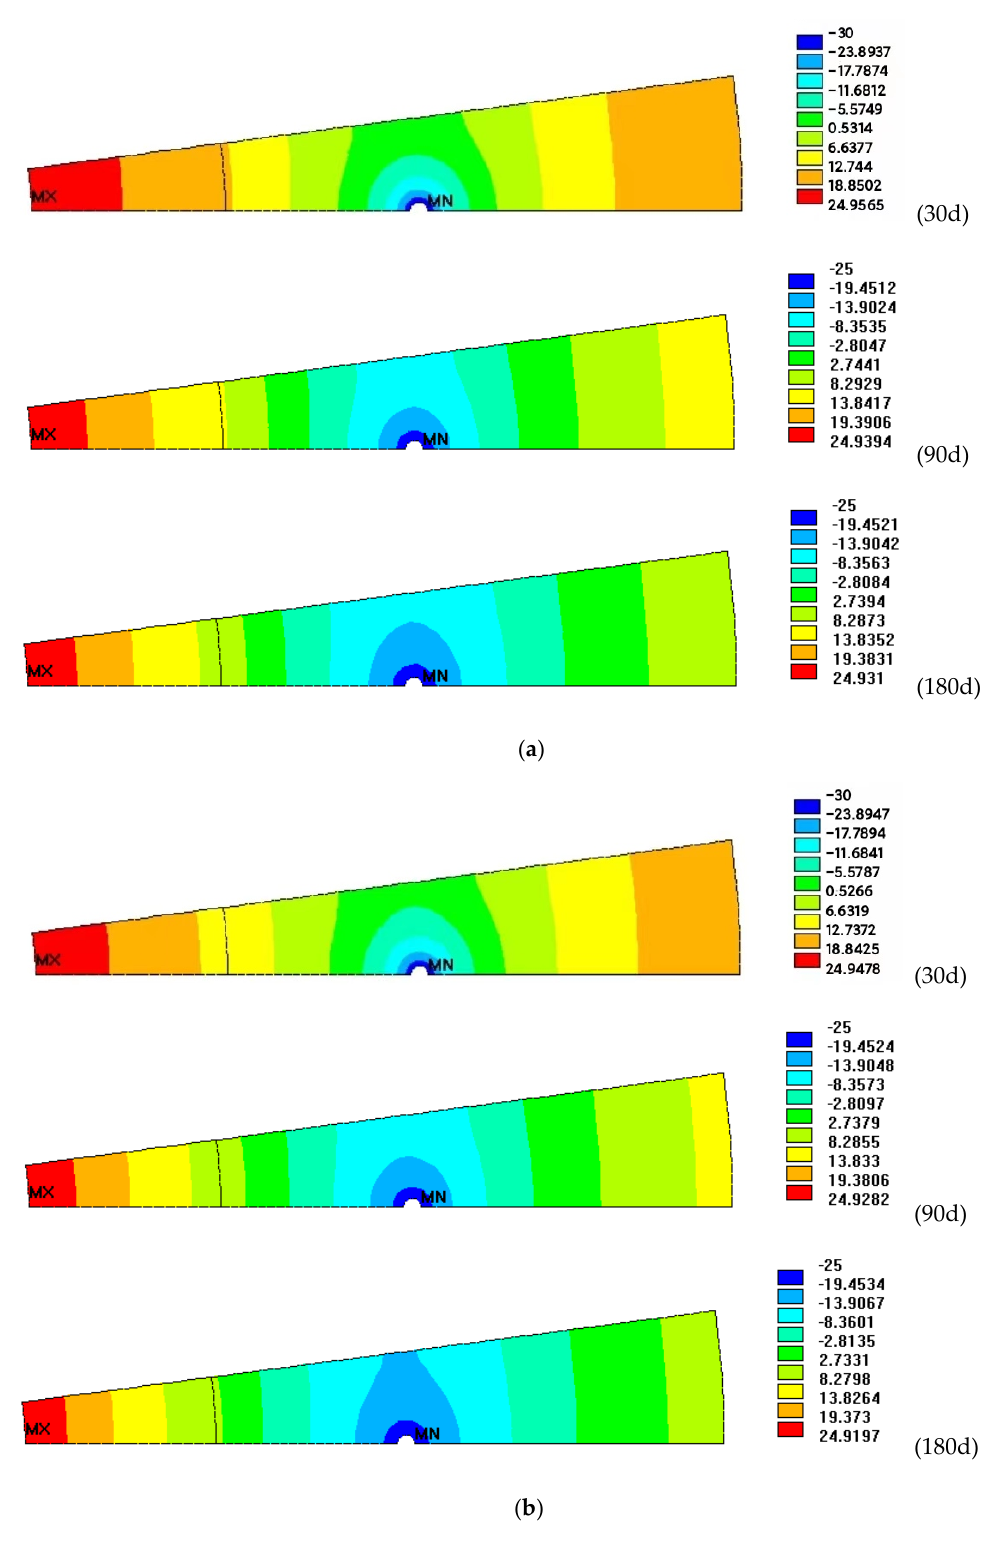
Figure 17. Temperature contours within 30d, 90d and 180d: ( a ) thermal conductivity of unfrozen soil of 1.2 W ∙ m − 1 °C − 1 , ( b ) thermal conductivity of unfrozen soil of 1.5 W ∙ m − 1 °C − 1 . soil of 1.2 W · m − 1 · ◦ C − 1 , ( b ) thermal conductivity of unfrozen soil of 1.5 W · m − 1 · ◦ C − 1